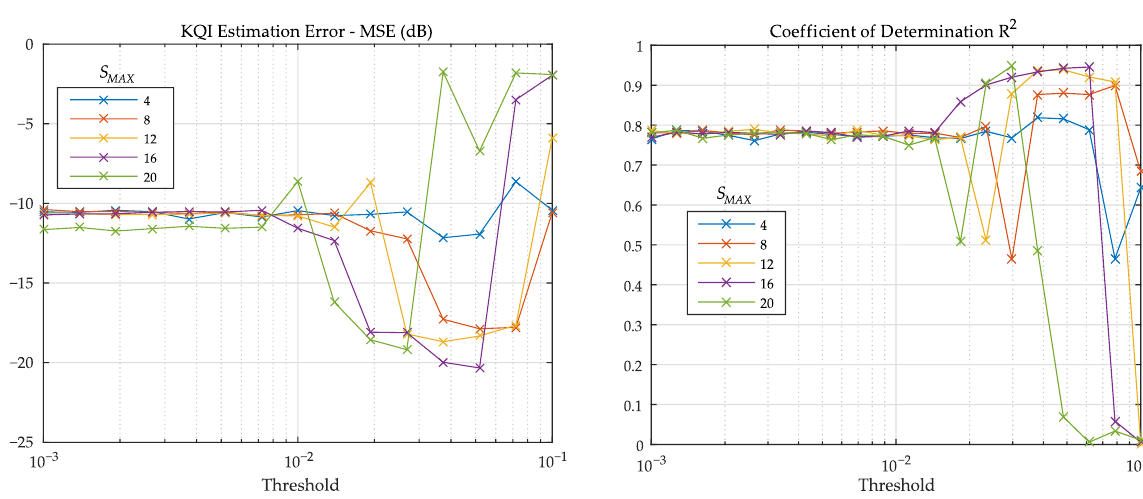
Figure 10. Estimation MSE ( left ) and coefficient of determination R 2 ( right ) as a function of prediction error threshold γ MAX using different values for the maximum number of segments S MAX .